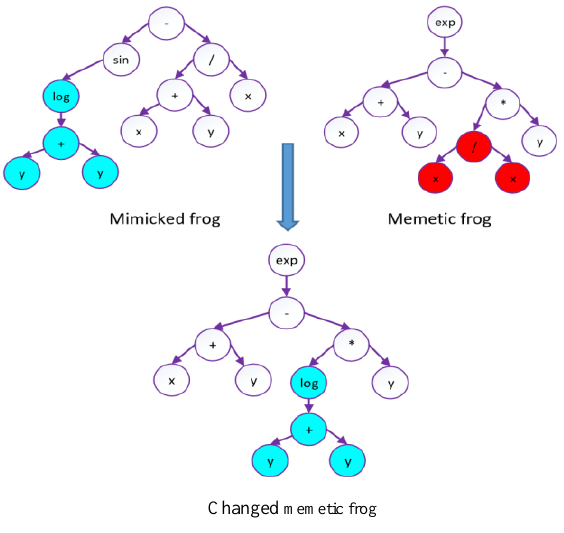
Figure 3. Proposed Cross-over.